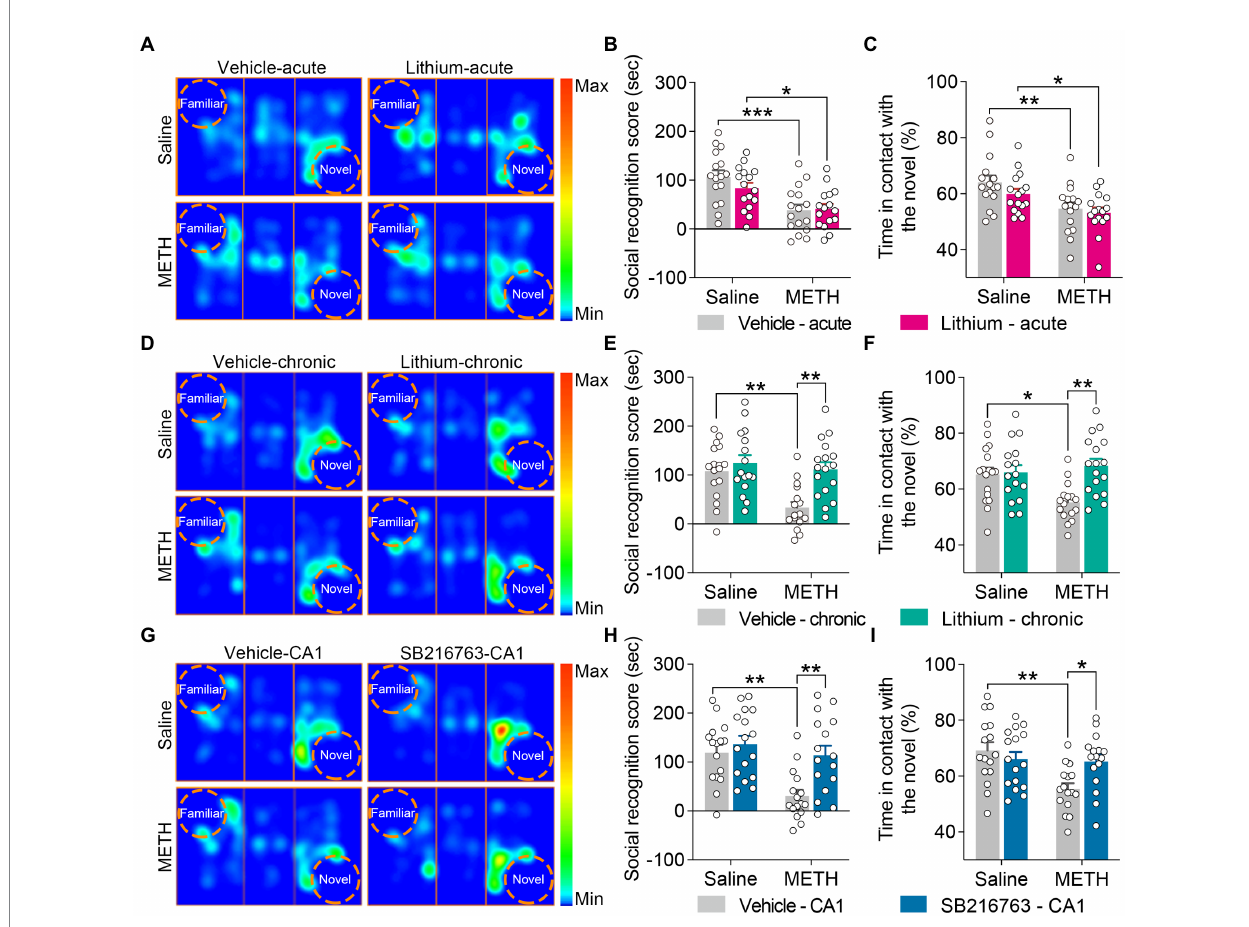
FIGURE 4 Effect of GSK3 β inhibition on adolescent METH exposure-induced social recognition memory impairment in adulthood. Acute systemic intervention (A–C) had no significant effects on adolescent METH exposure-induced social behavioral deficit, while chronic systemic intervention (D–F) and chronic intervention within CA1 (G–I) rescued adolescent METH exposure-induced social recognition memory impairment in adulthood. Representative heat maps show the location of the mice during the social recognition memory test (A,D,G) . Histograms show the social recognition score (B,E,H) and time in contact with the novel (%) (C,F,I) during the social recognition memory test. Data are presented as the mean +/ − SEM, each symbol represents the independent of a single animal; two-way ANOVA followed by the Bonferroni post hoc test; n = 16 ~ 17/group; * p < 0.05, ** p < 0.01, and *** p < 0.001, comparison between the two indicated groups. See also Supplementary Figure